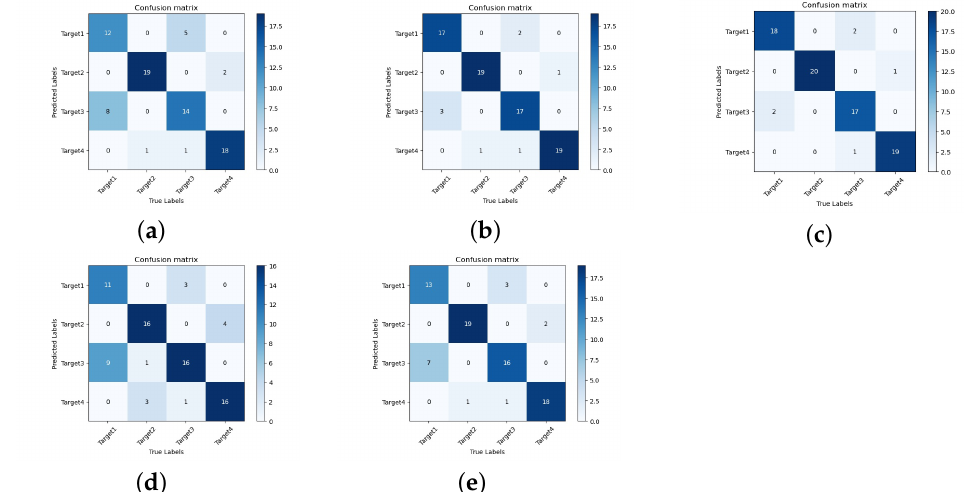
Figure 18. The confusion matrices of different models. ( a ) Baseline. ( b ) EfficientNet-S. ( c ) EfficientNet- S+SGAN. ( d ) IAFNet. ( e )